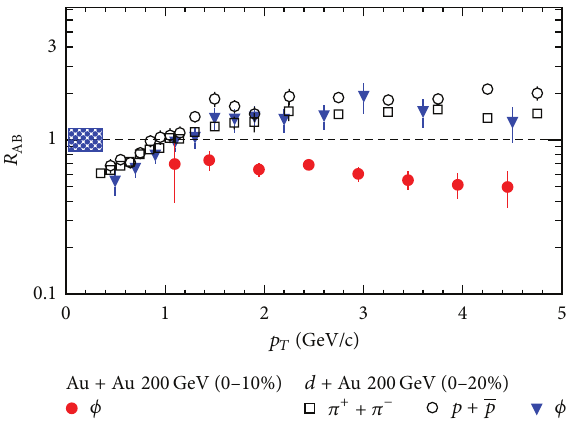
as a function of AB √𝑠 = 𝑁𝑁